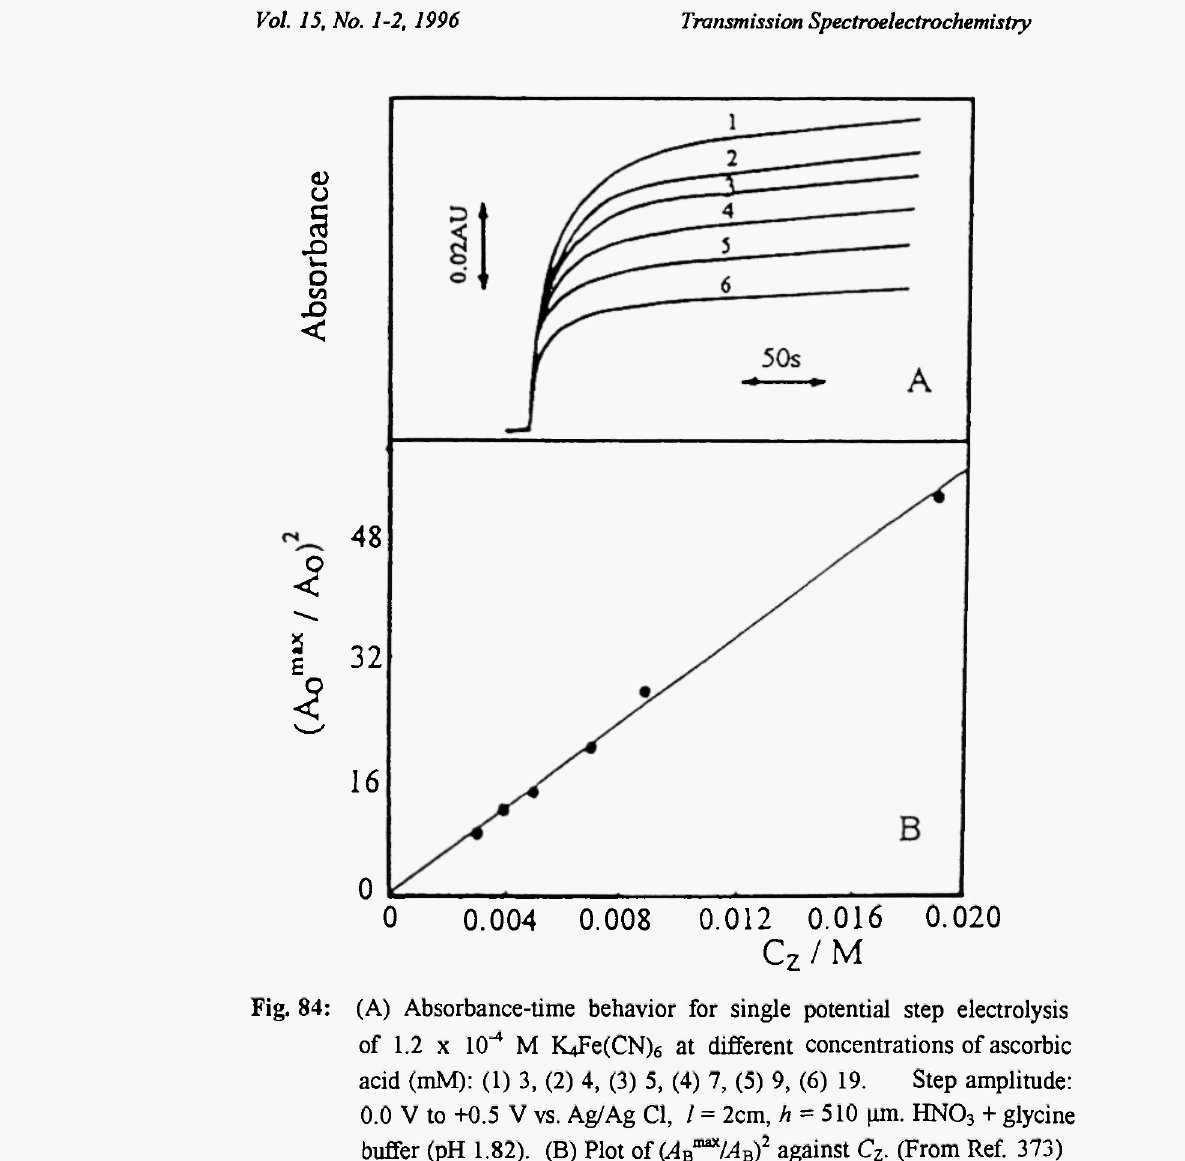
Fig. 84: (A) Absorbance-time behavior for single potential step electrolysis of 1.2 χ 10" 4 Μ K4Fe(CN) 6 at different concentrations of ascorbic acid (mM): (1) 3, (2) 4, (3) 5, (4) 7, (5) 9, (6) 19. Step amplitude: 0.0 V to +0.5 V vs. Ag/Ag CI, / = 2cm, h = 510 μιη. HN0 3 + glycine buffer (pH 1.82). (B) Plot of {A^/A^) 2 against C z . (From Ref. 373)